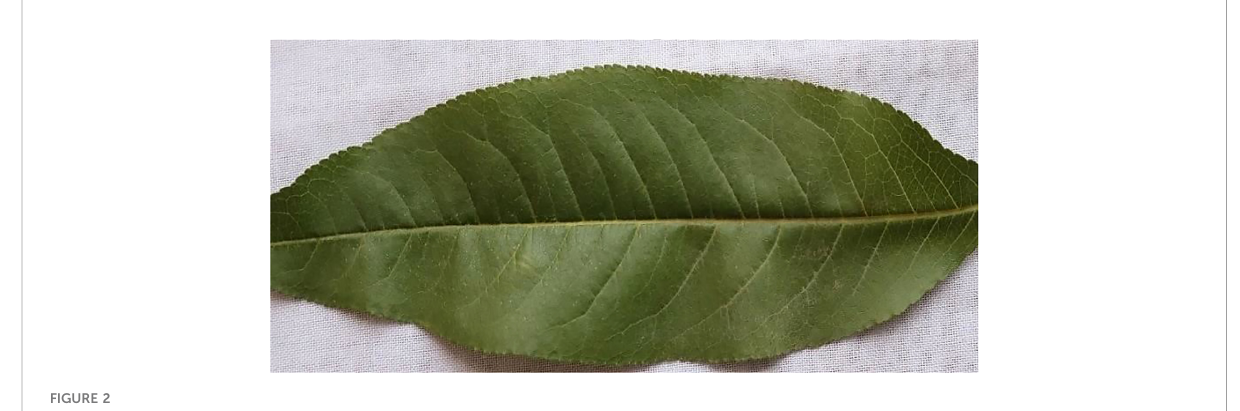
FIGURE 2 Healthy image of the peach